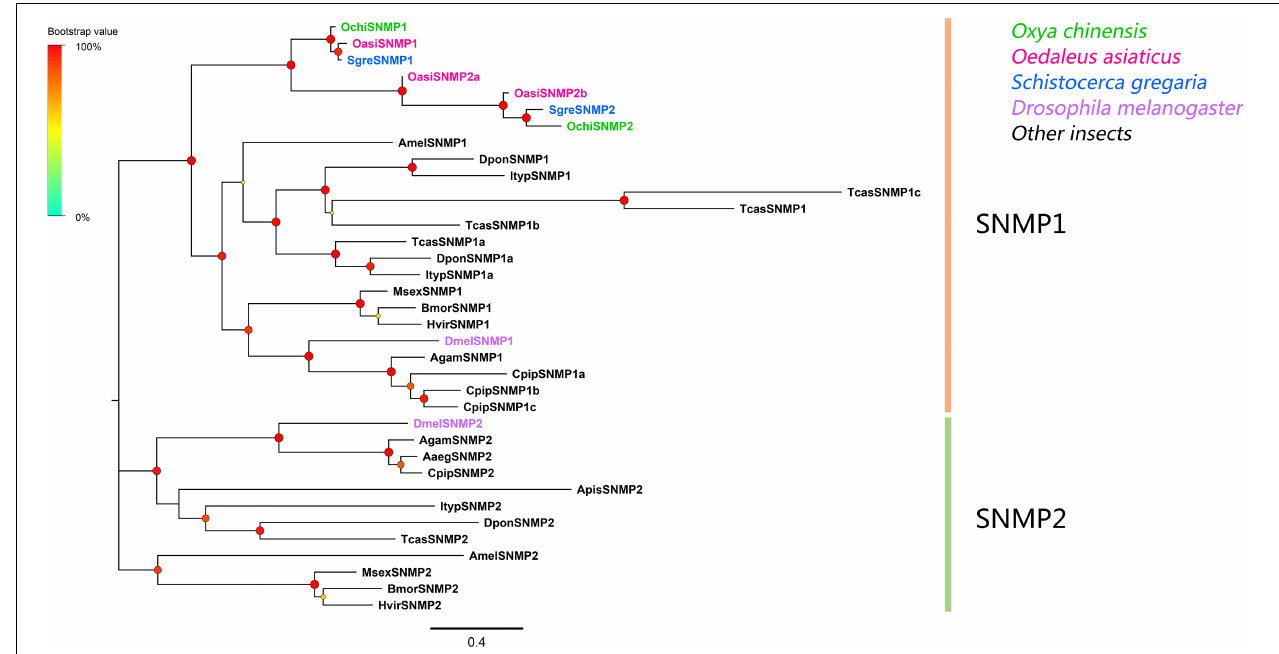
FIGURE 5 | Phylogenetic tree of putative sensory neuron membrane proteins (SNMPs). Branch support (circles at the branch nodes) was estimated using an approximate likelihood ratio test based on the scale indicated at the top left. Bars indicate branch lengths in proportion to amino acid substitutions per